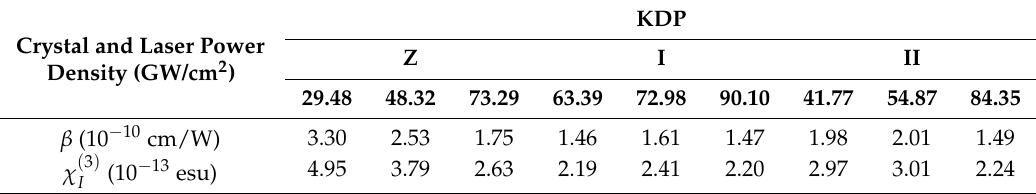
Table 1. Calculated results of nonlinear absorption parameters for KDP crystals at λ = 532 nm.